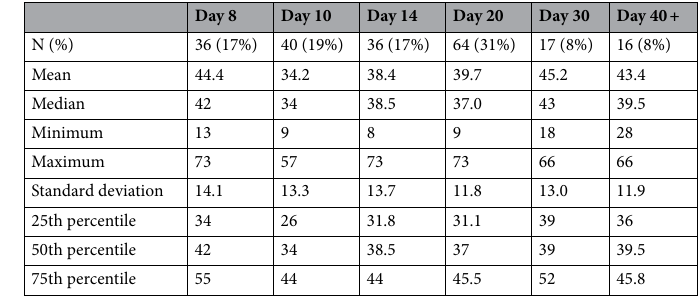
Table 2. Time to SARS-CoV-2 RT-PCR conversion from positive to